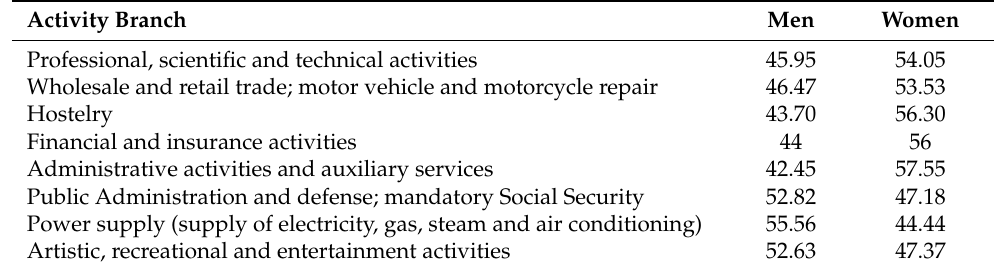
Table 3. Activity branches that show gender parity in the percentage distribution of